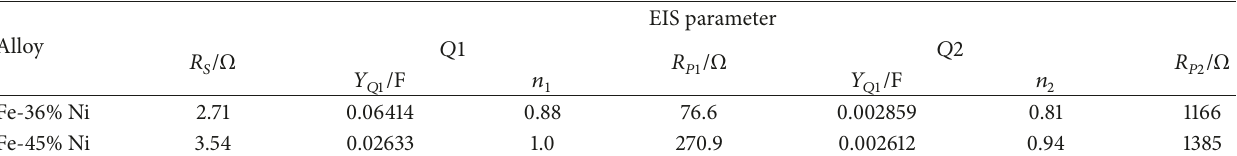
Table 2: Electrochemical impedance spectroscopy parameters obtained for Fe-36% Ni and Fe-45% Ni alloys after their immersions in 1M HCl solutions.